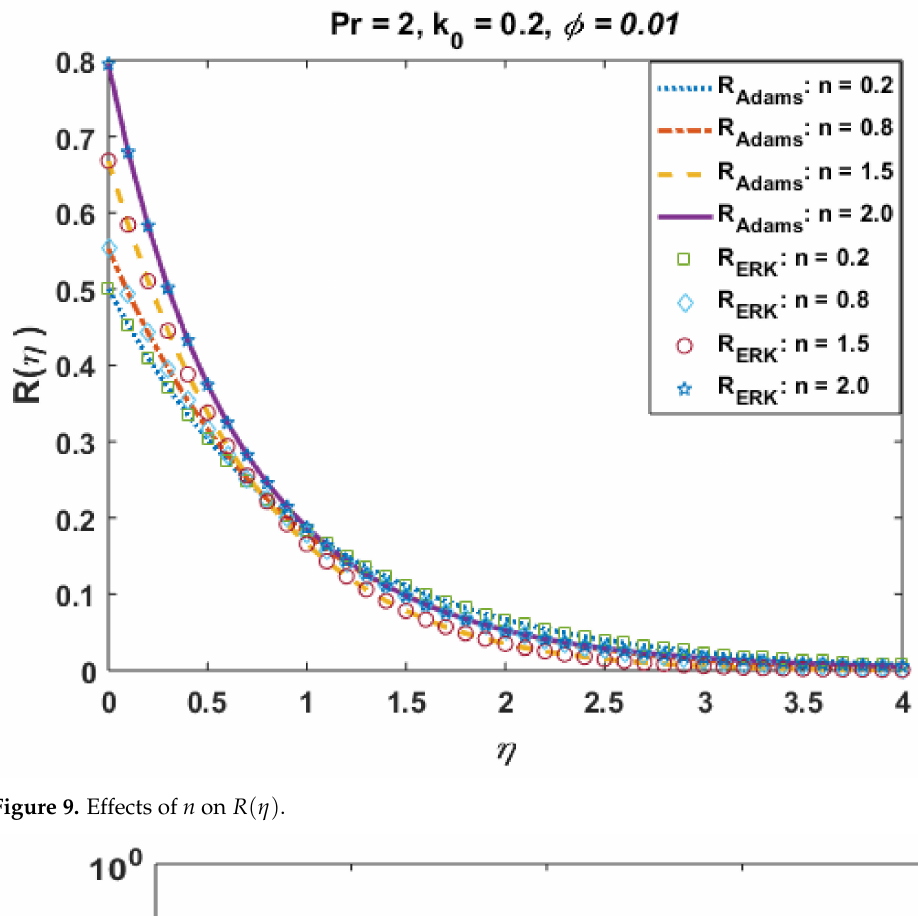
Figure 9. Effects of n on R ( η ) .